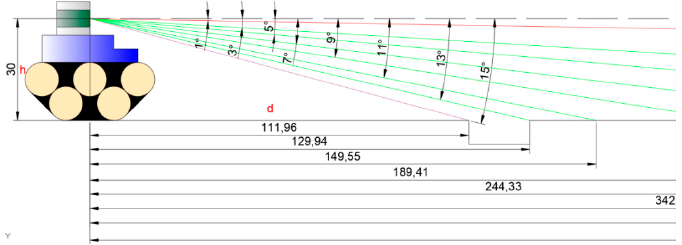
Figure 15. Schematic diagram of negative obstacle detection range estimation.